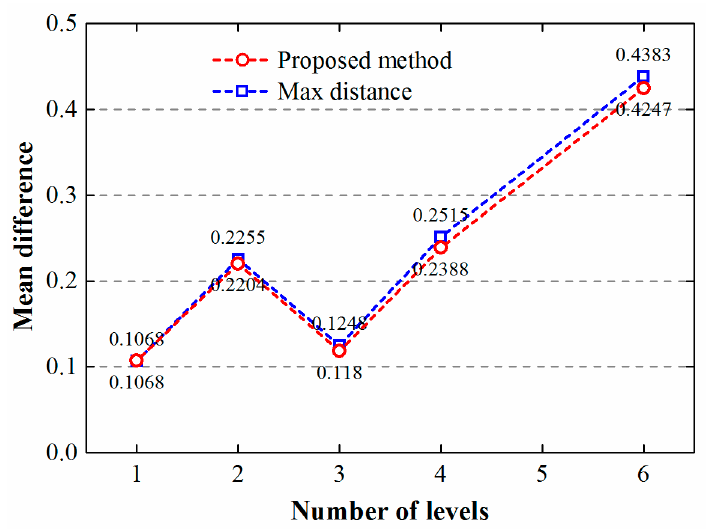
Figure 7. Mean difference of generalized results versus number of levels. Mean difference is the absolute difference between total building area and the total area of generalized objects, normalized by the total building area.